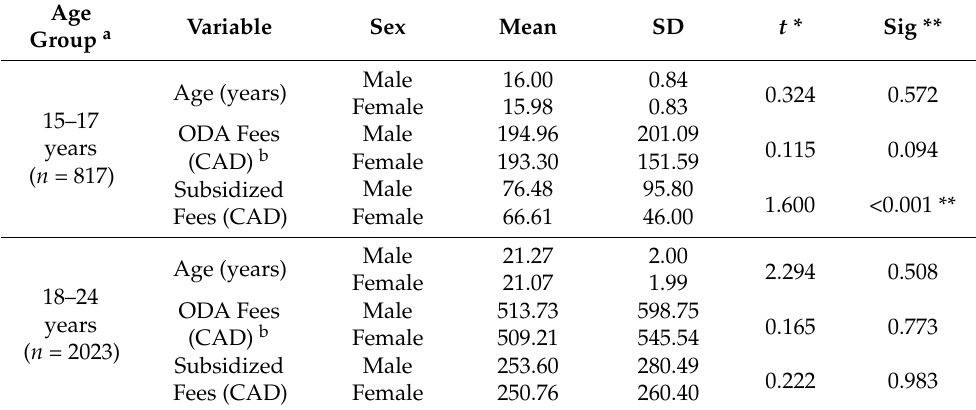
Table 1. Characteristics of study